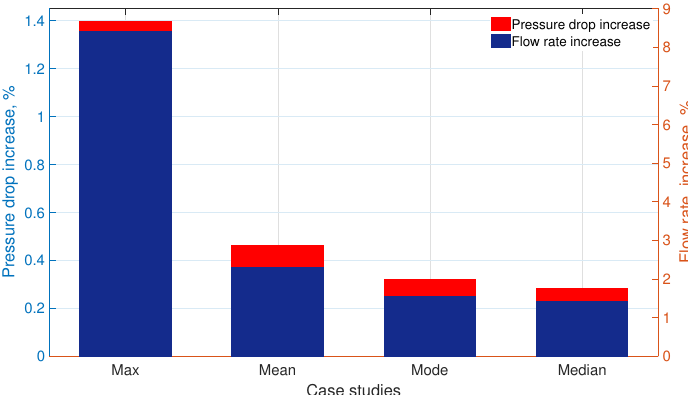
Figure 8. Pressure drop and flow rate increase after H 2 injection throughout pipe 10.